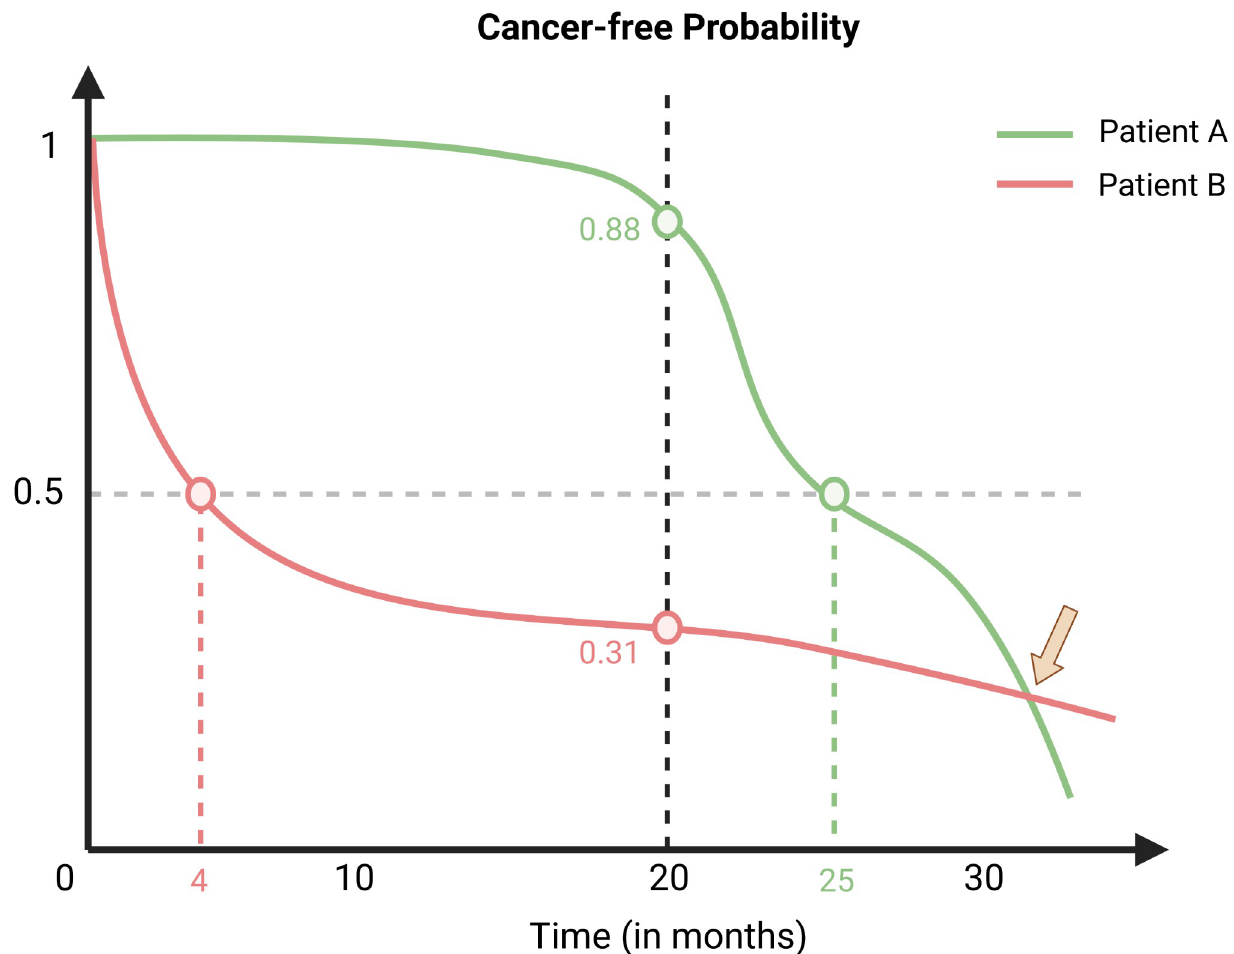
Fig 1. ISDs of two example participants–Patient A in green and B in red. Note that the ISD provides a person’s probability of being cancer-free, for each future time t , and the BCaO probability at time t is ( 1—cancer-free-probability(t) ). Some useful statistics that can be computed from ISDs: the intersection of a patient’s ISD with the median probability line (the horizontal line at 0.5) is the median BCaO time for that patient; the intersection of an ISD with the vertical line at a target time (e.g., at 20 months) provides the cancer-free probability at that specific time-point. Note that, in general, multiple ISDs are allowed to crossover (shown with an arrow) as each patient has her own ISD computed from her specific features (unless a model assumes proportional